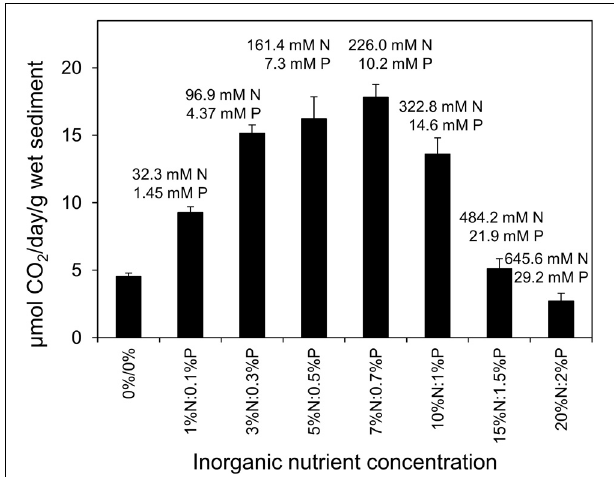
FIGURE 5 | Effect of inorganic N treatment (0–20% w/w of oil) with 1/10 th P treatment on the rate of CO 2 production in microcosm comprising 10g beach sediment and 125mg North Sea crude oil. Sodium nitrate and potassium dihydrogen phosphate were used as N and P sources. For easy cross referencing to Figure 4 , each point is annotated with the concentration of N and P in millimolar terms, based on the water content of the sediments. Each data point represents average value of three replicates. One percent N by weight of oil is equivalent to approximately 9 micromoles of N per g sediment and 20% N is equivalent to 178 micromoles of N per g sediment.